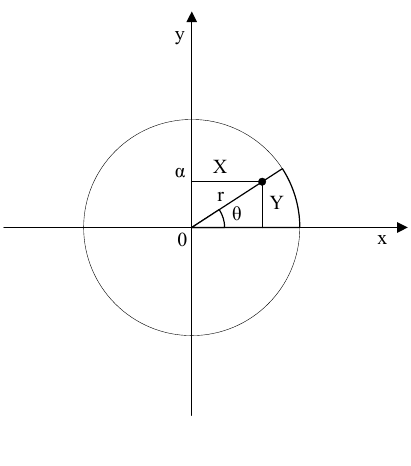
Figure 1. Polar method of